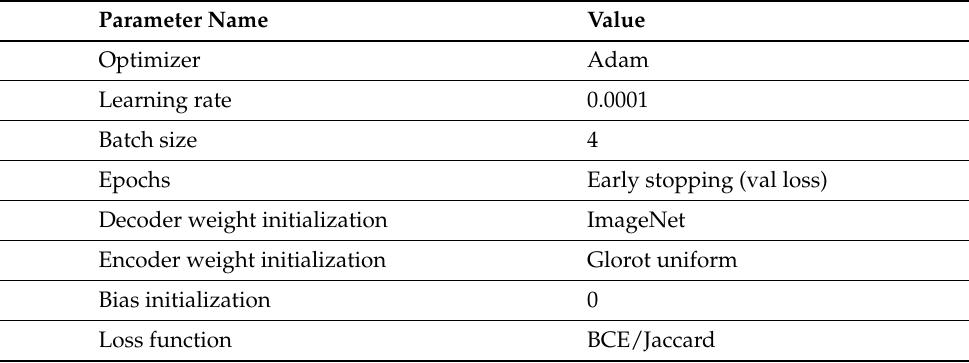
Table 5. Training hyperparameters of SegNet and